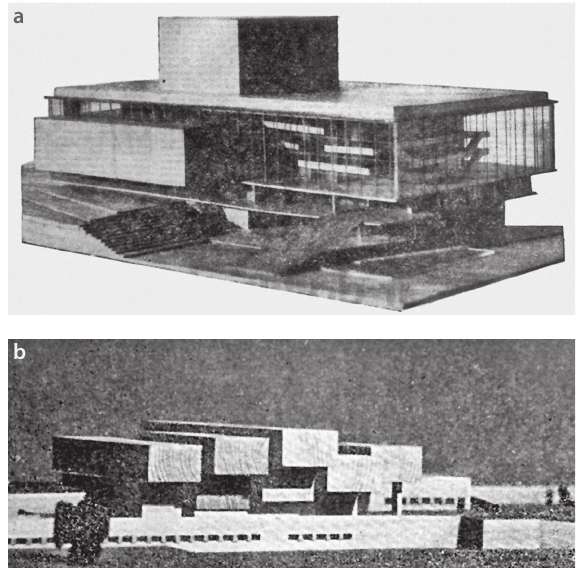
fig. 4. Model of Vilnius opera and Ballet Theatre, architect n. Bučiūtė, 1963 (a); Model presented for the competition for the Museum of revolution (present national art Gallery) in Vilnius, architects G. Baravykas, P. adomaitis, V. Vielius and r. Pranaitis, 1966